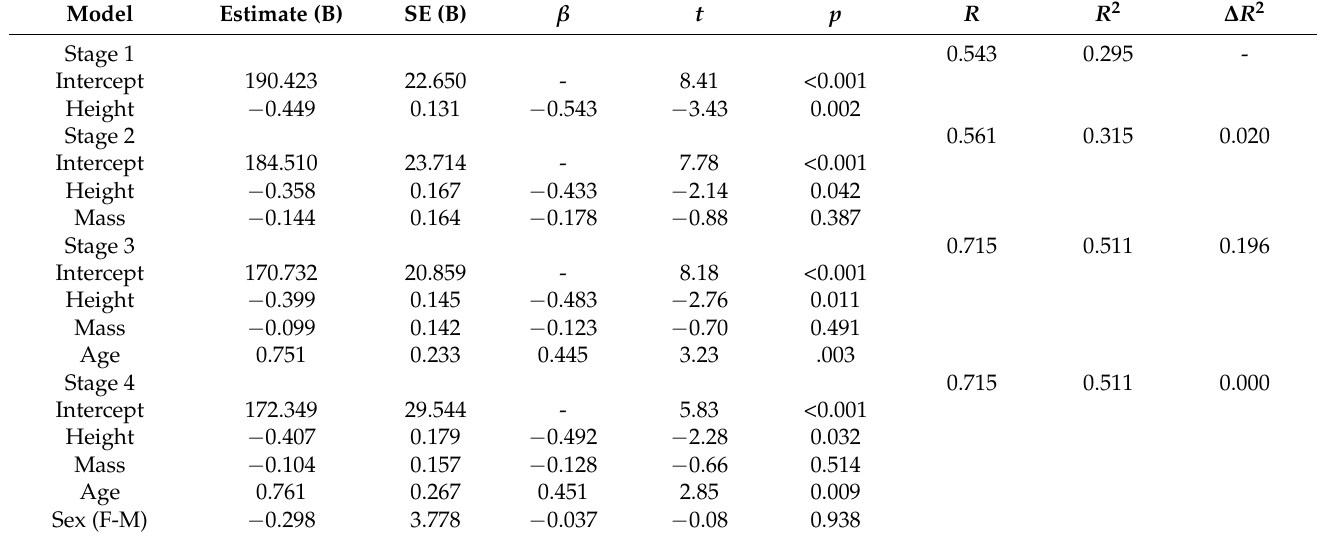
Table 3. Regression results for cadence.